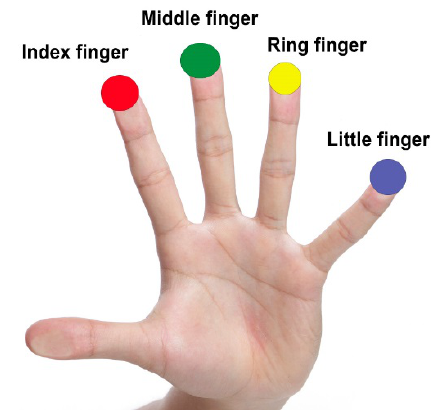
Figure 1. Distribution of colours by finger.